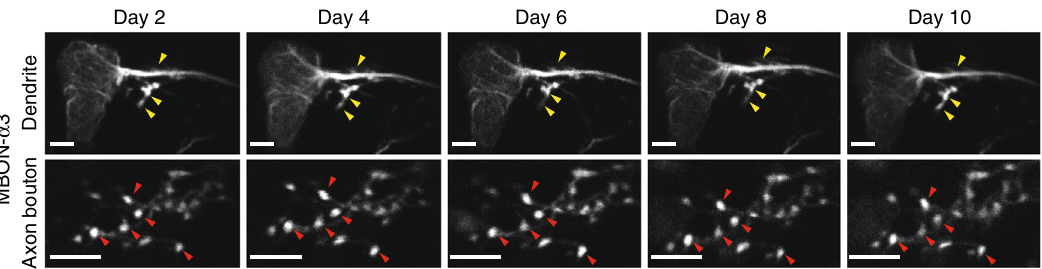
Fig. 4 Long-term in vivo imaging of neural structure. Time-lapse two-photon imaging of the dendritic arbor (upper) and axonal boutons (lower) of a fl uorescent mushroom body output neuron (MBON- α 3) in a live fl y ( MB093C-GAL4 > 20 × UAS-6 × GFP ). Major dendritic structures (yellow arrowheads) and axonal boutons (red arrowheads) were stable for 10 days. Scale bars: 10 μ m. See also Supplementary Fig. 2 for additional time-lapse image datasets